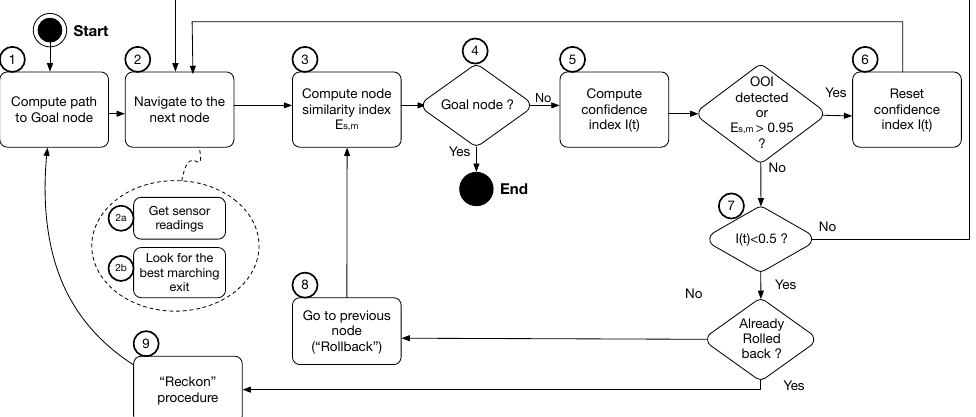
Figure 4. Navigation procedure flow chart (see text below for a detailed description). Step 2 is composed of two